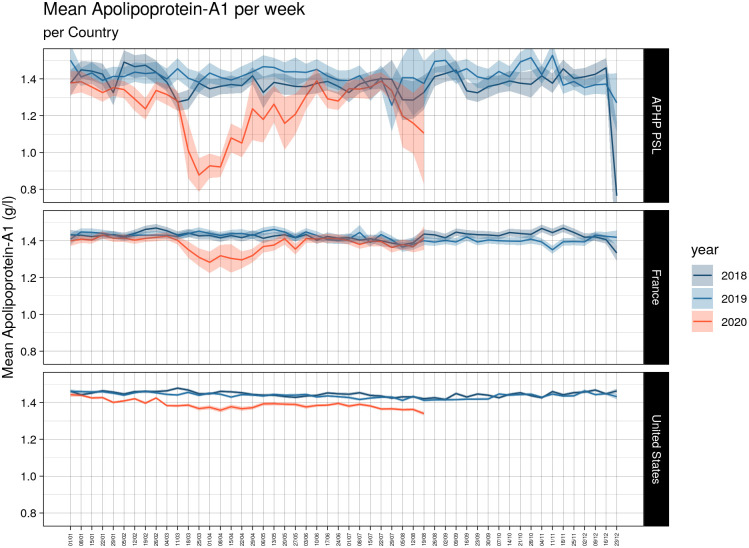
Quantitative decrease of apolipoprotein-A1 by cohort.Apolipoprotein-A1 decreased (P<0.001) in the three cohorts, starting early in January 2020 (red line with 95% confidence interval) in the US cohort (lower panel).